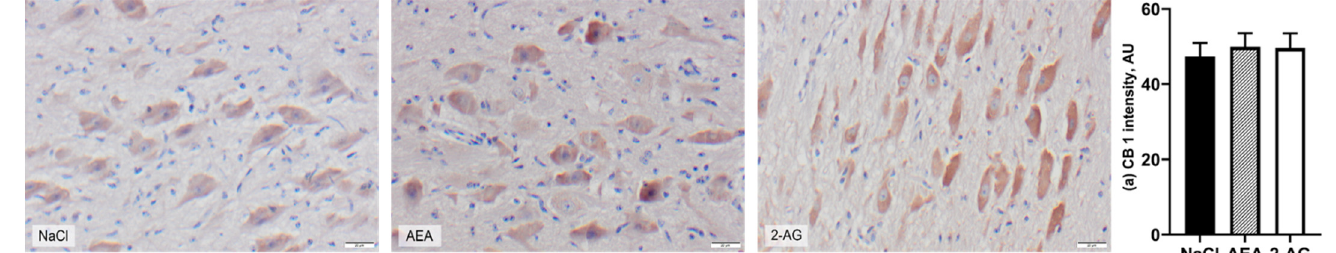
Figure 3. Representative images of DAB-stained CB1-expressing neurons in the periventricular nucleus (PVN) of cows after intraperitoneal administration with NaCl ( n = 7), AEA ( n = 7) or 2-AG ( n = 6) for 9 days. CB1 immunoreactivity was visualized with DAB (arbitrary units, AU) and nuclei were stained with hemalaun (blue). Scale bar within images indicates 20 µm. CB1 intensities ( a ) are shown as LSM ± SE with F (2,15) = 0.15, p = 0.86 (ANOVA).